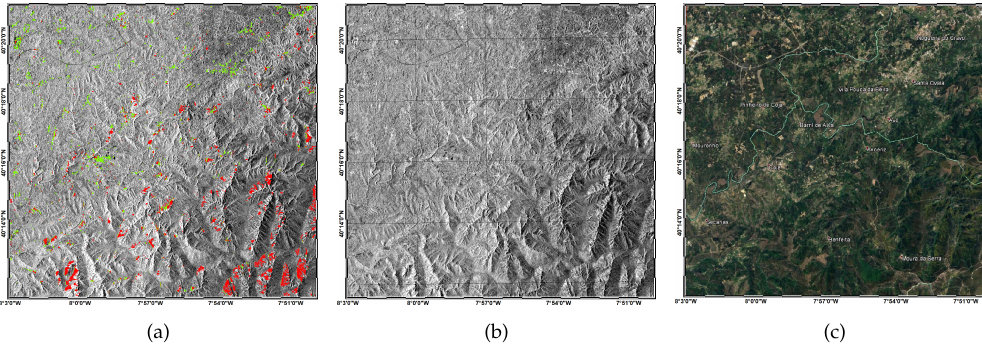
Figure 6. Illustration of the removal of foreshortening regions with building-like backscattering values, Portugal. ( a ) Red—areas removed by the topography filter, green—areas retained by the topography filter in the S1BM product; ( b ) intensity image; ( c ) optical image of the scene (source: Google Earth). areas. Moreover, the systematic S-1 acquisition plan allows us to frequently update buildings maps at 468